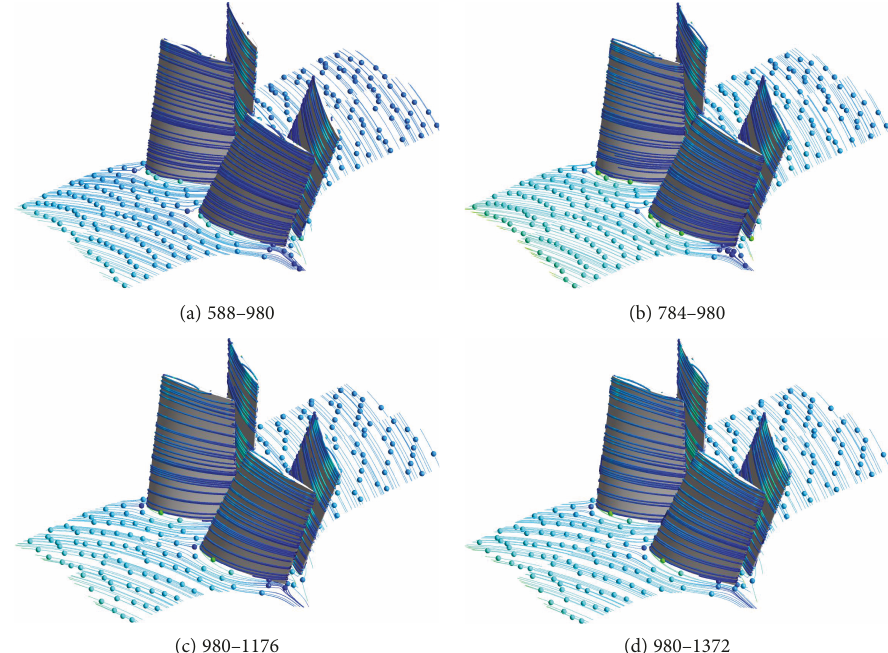
Figure 13: Streamline diagram of CRF with rotating speed variation under large fl ow